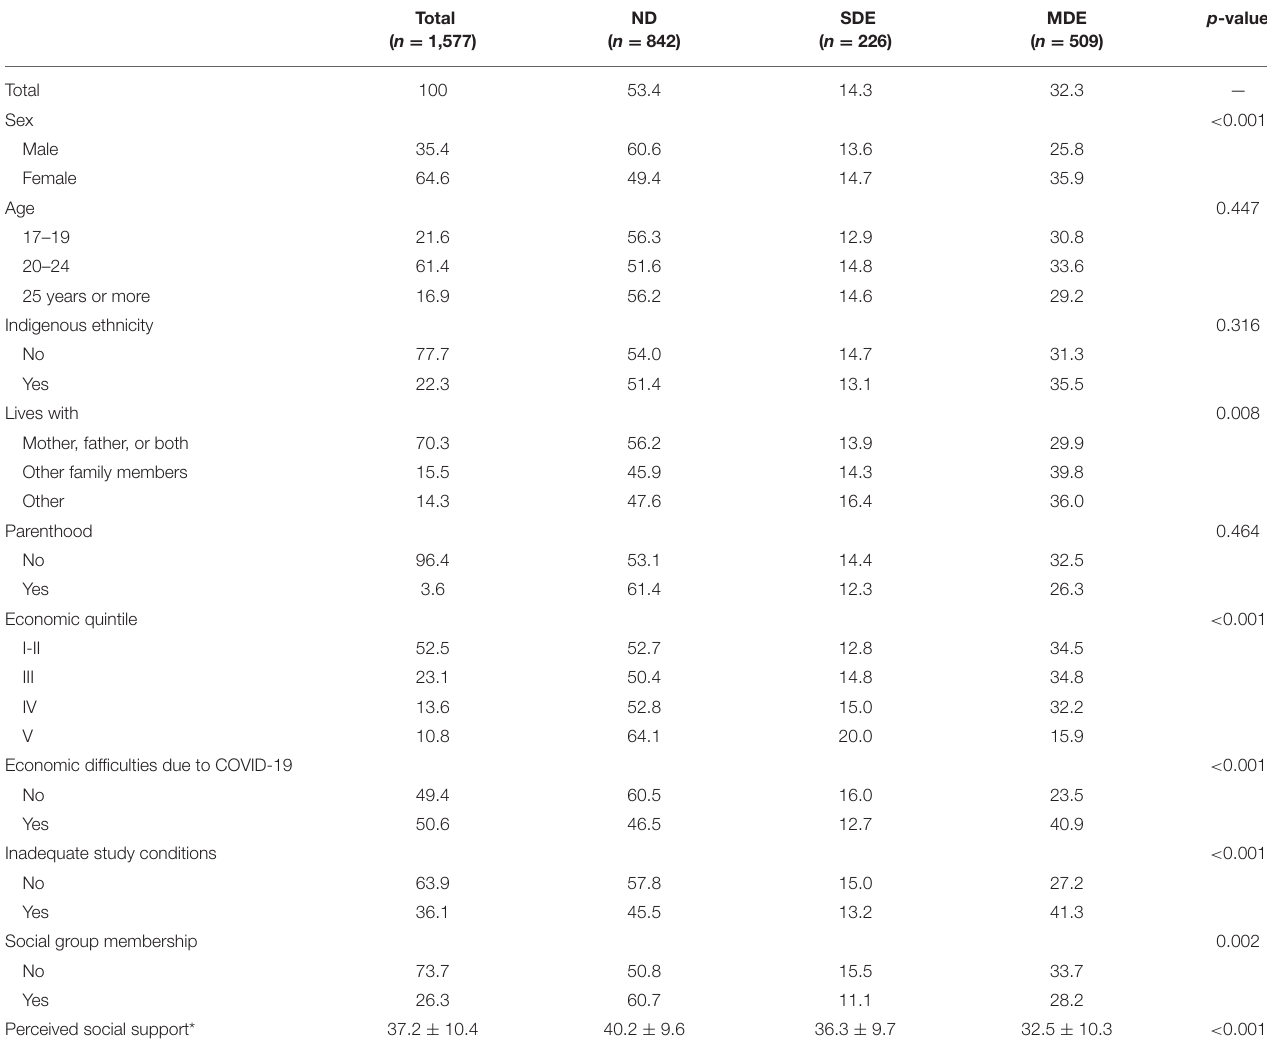
TABLE 1 | Prevalence of SDE and MDE by social and economic